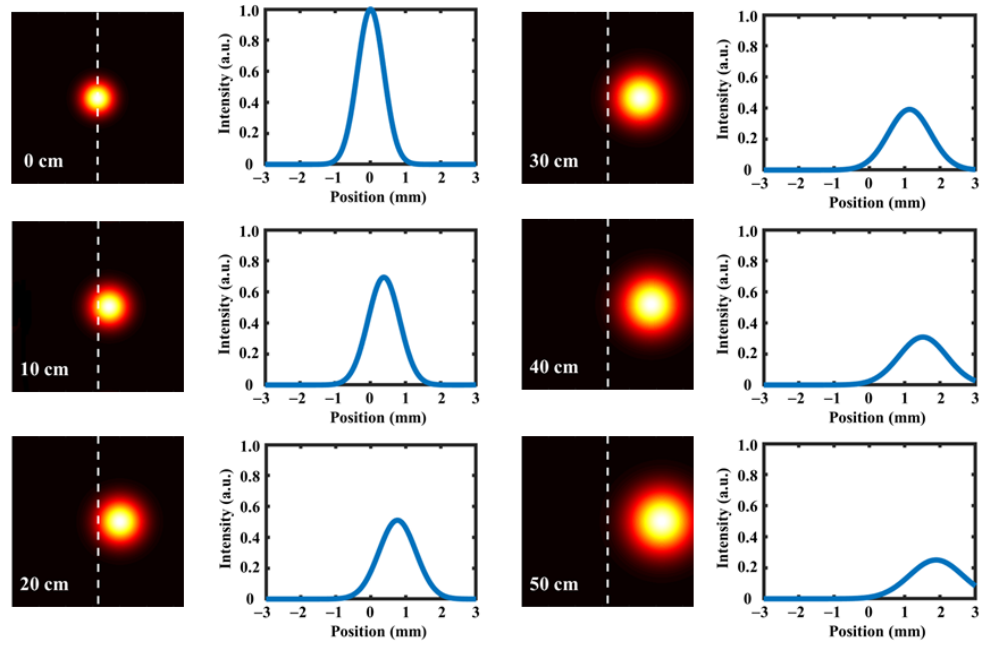
Figure 5. Simulation results of the light field and corresponding intensity distribution captured at different positions away from the compound FLC lens with right-handed circularly polarized input light.